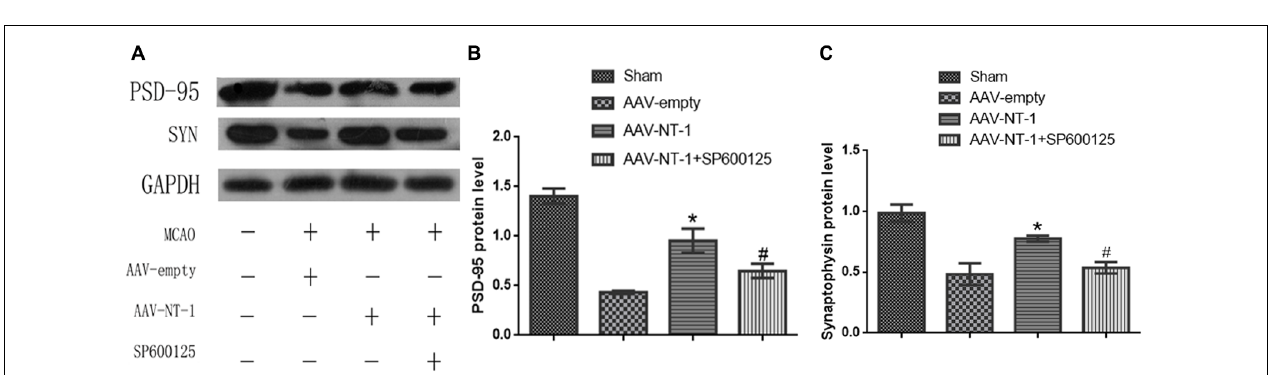
FIGURE 6 | Effects of Netrin-1 overexpression and/or JNK inhibition on the synaptic formation after the MCAO. (A) The representative image of western-blot analysis for PSD-95 and synaptophysin. Rats in each group were sacrificed at Day 14 after the MCAO. (B) Western-blot analysis of PSD-95 ( n = 3), ∗ p < 0.01, as compared with the AAV-empty group; # p < 0.05, as compared with the AAV-NT-1+SP600125 group. (C) Western-blot analysis of synaptophysin ( n = 3), ∗ p < 0.05, as compared with the AAV-empty group; # p < 0.05, as compared with the AAV-NT-1 group.